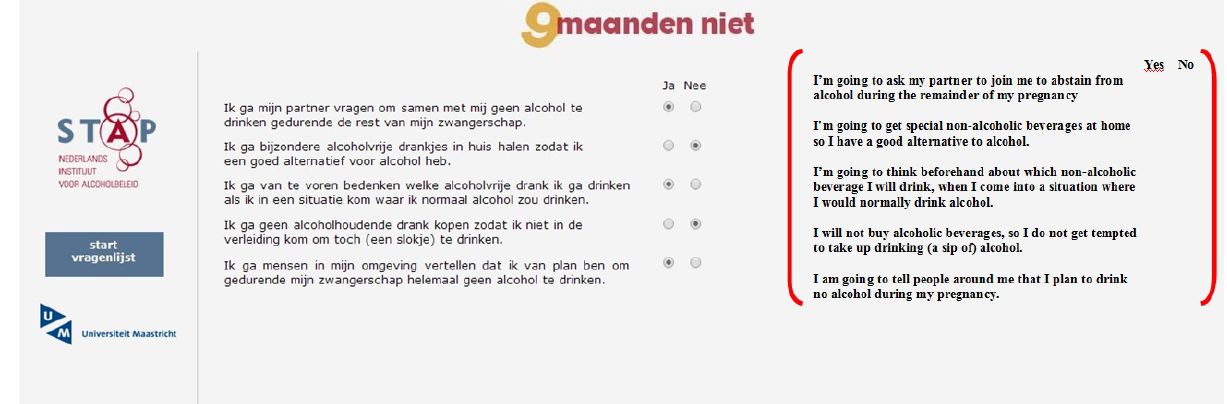
Figure 1. Screenshot and English translation of items regarding action plans to abstain from prenatal alcohol